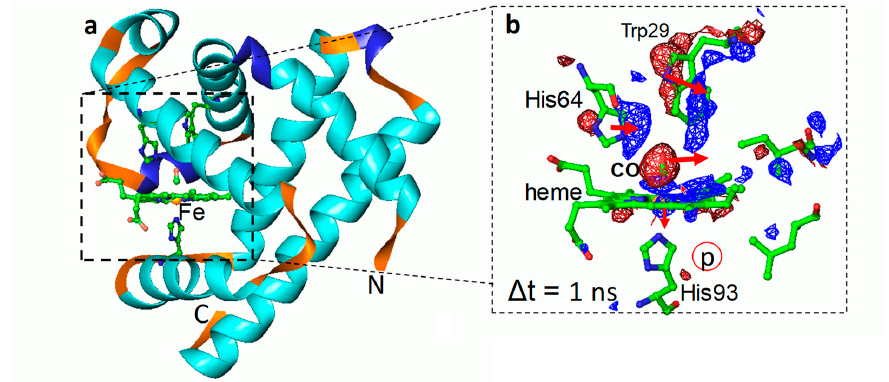
Figure 4. Time ‐ resolved crystallographic photoflash experiment on the L29W mutant of Mb–CO [66]. ( a ) Overall structure of Mb L29W –CO in the dark. Dashed box: heme pocket. Some important residues are displayed. The heme iron is shown as a yellow sphere. ( b ) Close ‐ up of the heme pocket 1 ns after an intense optical laser flash to start photodissociation of the CO from the heme. t. The heme and important residues are marked. Red: negative difference electron density; blue: positive difference electron density ( − /+ 3 σ contour levels, respectively). Red arrows show structural relaxations at this time delay. In this mutant, the Trp29 transiently occludes the primary docking site of the CO. CO is found at time delays >1 μ s on the proximal side of the heme (red ‐ circled p).